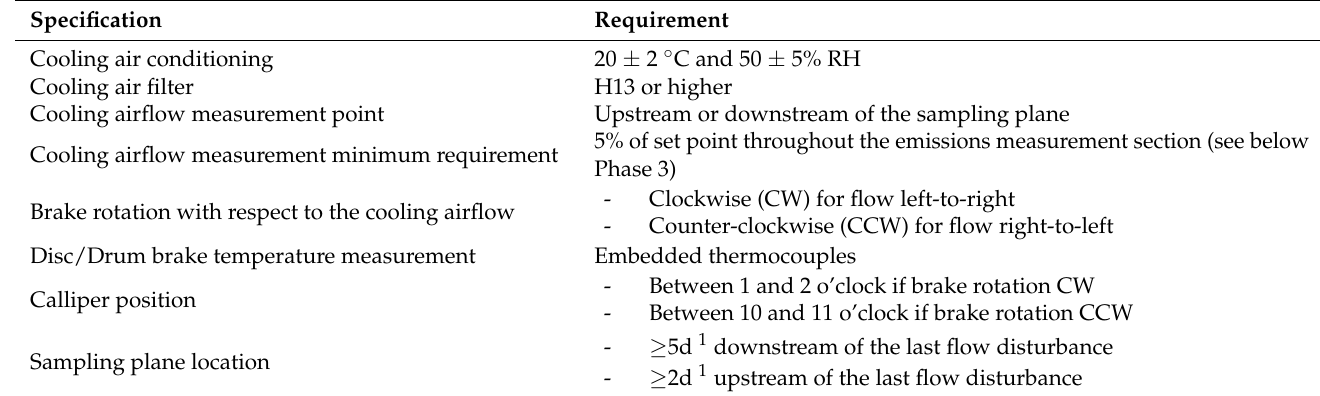
Table 2. Minimum system specifications applied at the